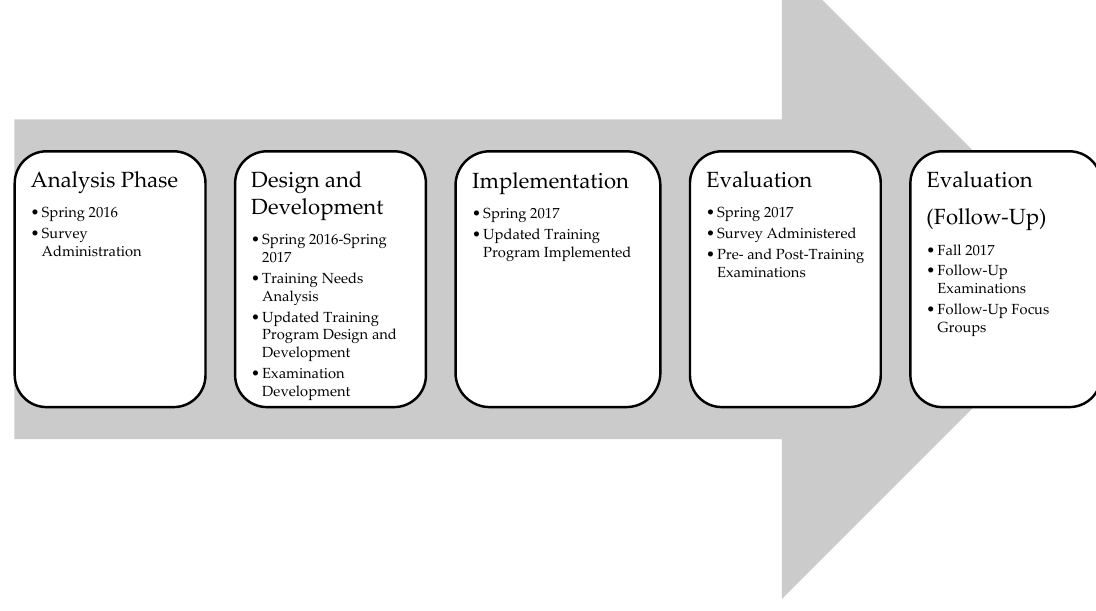
Figure 1. Research timeline and activities.